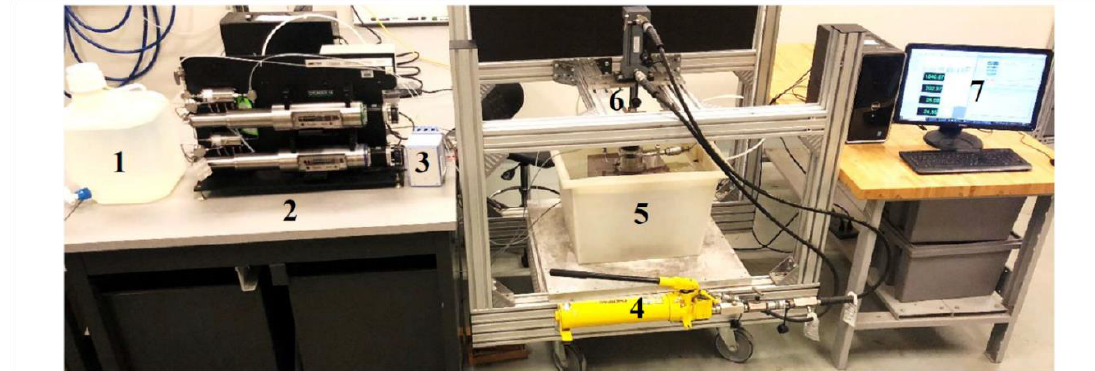
Figure 4. A view of the experimental facility.